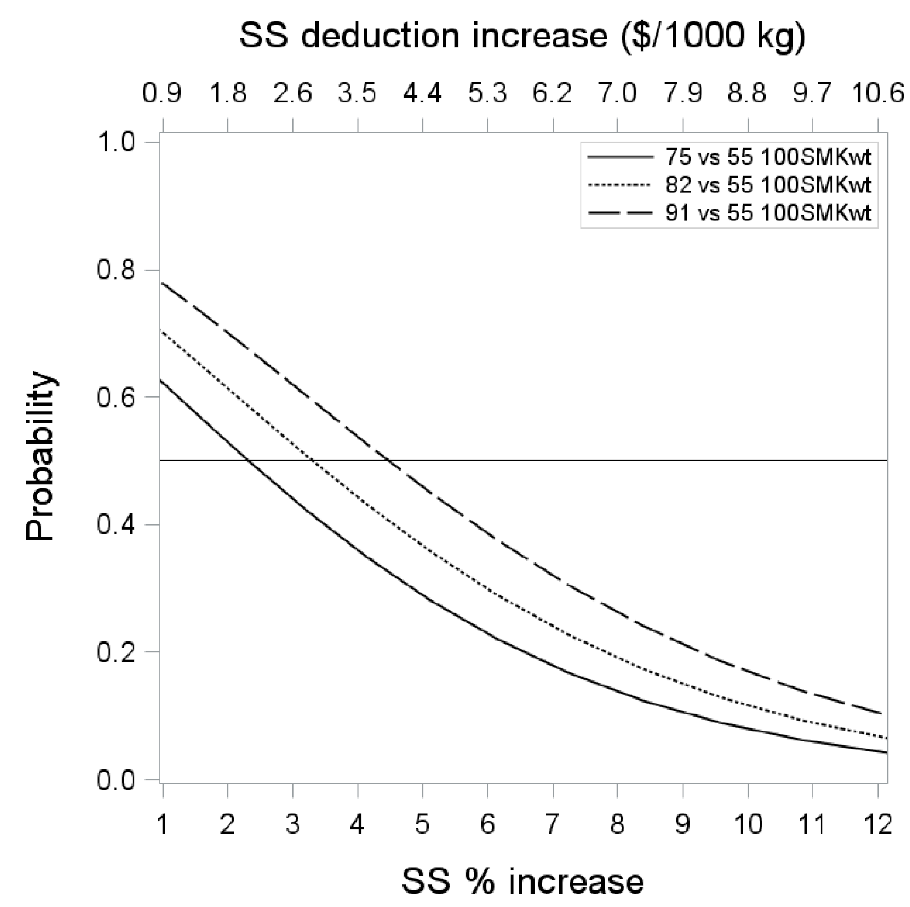
Figure 4. Estimated probability of increased sound splits (SS) and corresponding SS deduction follow- ing shelling runner market type pods with a standard runner-type sheller screen on a reciprocating sheller for genotypes with sound mature kernels (SMK) sized 75, 82, and 91 g/kernel (605, 550, and 500 seed/lb, respectively) compared to 55 g/kernel (820 seed/lb). Selected sizes were based on estimated means from the current study and values reported in cultivar registrations for extra-large (e.g., TUFRunner ‘297′ and Florida-07) and small-seeded (e.g., Georgia-13M) runner-type cultivars. Linear robust regression models for kernel length as a function of SMK wt, and width and thickness aspect ratios predicted by kernel length were all highly significant ( p < 0.001) with respective robust R 2 values of 0.81, 0.83, and 0.89 (Figure 5). Mean kernel den- sity among reported estimates was 978 kg/m 3 , which did not significantly vary with SMK wt ( p = 0.589). Estimated kernel length, width, and thickness dimensions for selected ker- nel sizes calculated via SMK wt- and dimension-based regression or density were similar between the two methods and are listed in Table 4. Table 4. Length ( L ), thickness ( T ), width ( W ), and aspect ratios for width ( W / L ) and thickness ( T / L ) estimated for selected